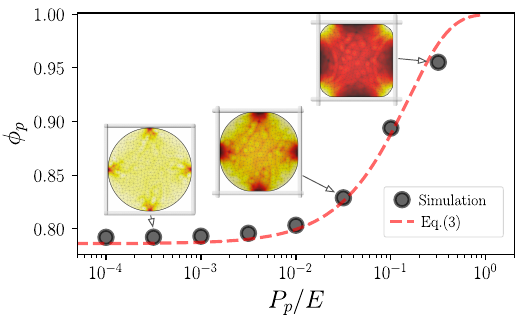
Figure 3. Compaction behavior of a single particle under isotropic compression. The dashed red line shows the analytical expression in Eq. (3) nicely fitting the results of our simulations. Screenshots show the deformed state of the particles inside the squared box.